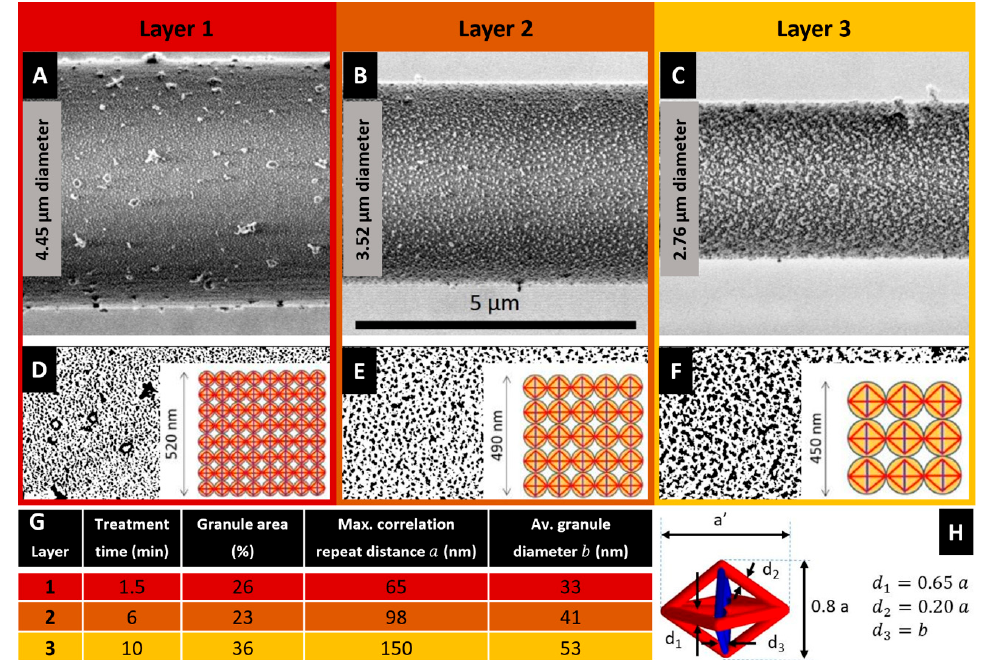
Figure 1. ( A – C ) SEM micrographs obtained after plasma etching at di ff erent exposure times of the same Nephila inaurata silk fibre. The analysed fibre had an initial diameter of 5.02 µ m and was spun at a reeling speed of 20 mm / s. ( D – F ) Particle analysis of the nanostructures observed in the above panels respectively. Insets: Variable size of the proposed tensegrity units. ( G ) Statistical analysis of size and distribution of the crystalline granules nanostructures the proposed tensegrity units are based upon. ( H ) Geometry of a generic unit: a and a’ denote the transverse and longitudinal dimensions of the unit, respectively; d 1 , d 2 and d 3 indicate the diameters of the individual